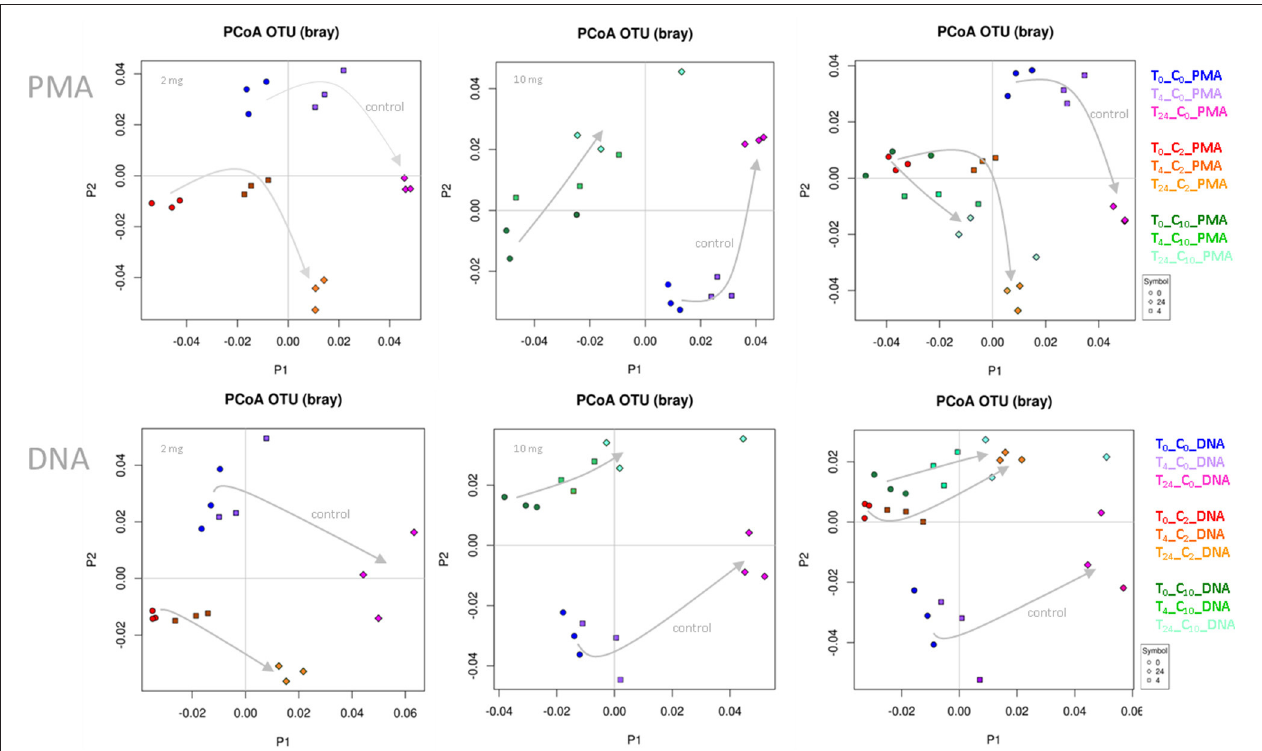
FIGURE 1 | PCoA plots based on Bray-Curtis distance. Data points of WBE-treated samples clustered together and separate from control samples. The two concentrations of WBE (given in each upper left corner of the plot) affected the microbial composition differently. (C 0 , PBS control sample; C 2 , 2mg WBE/ml HFS; C 10 , 10mg WBE/ml HFS; DNA, PMA-untreated; PMA, PMA-treated prior to DNA